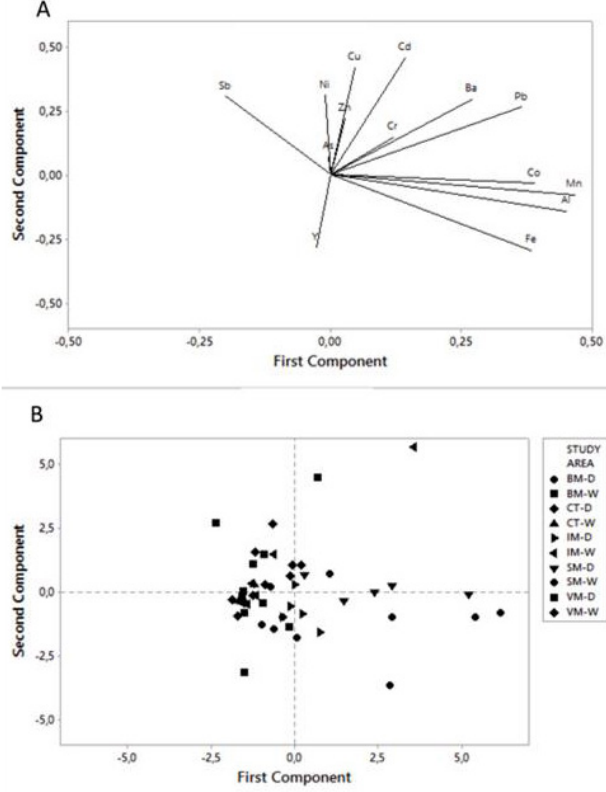
Fig 3 . Loading Plot (A) and Score Plot (B) - Principal components 1 and 2 - obtained from mean composition of mineral elements in 40 dehydrated bee pollen samples from four areas in the Iron Quadrangle in dry (D) and wet (W) seasons.